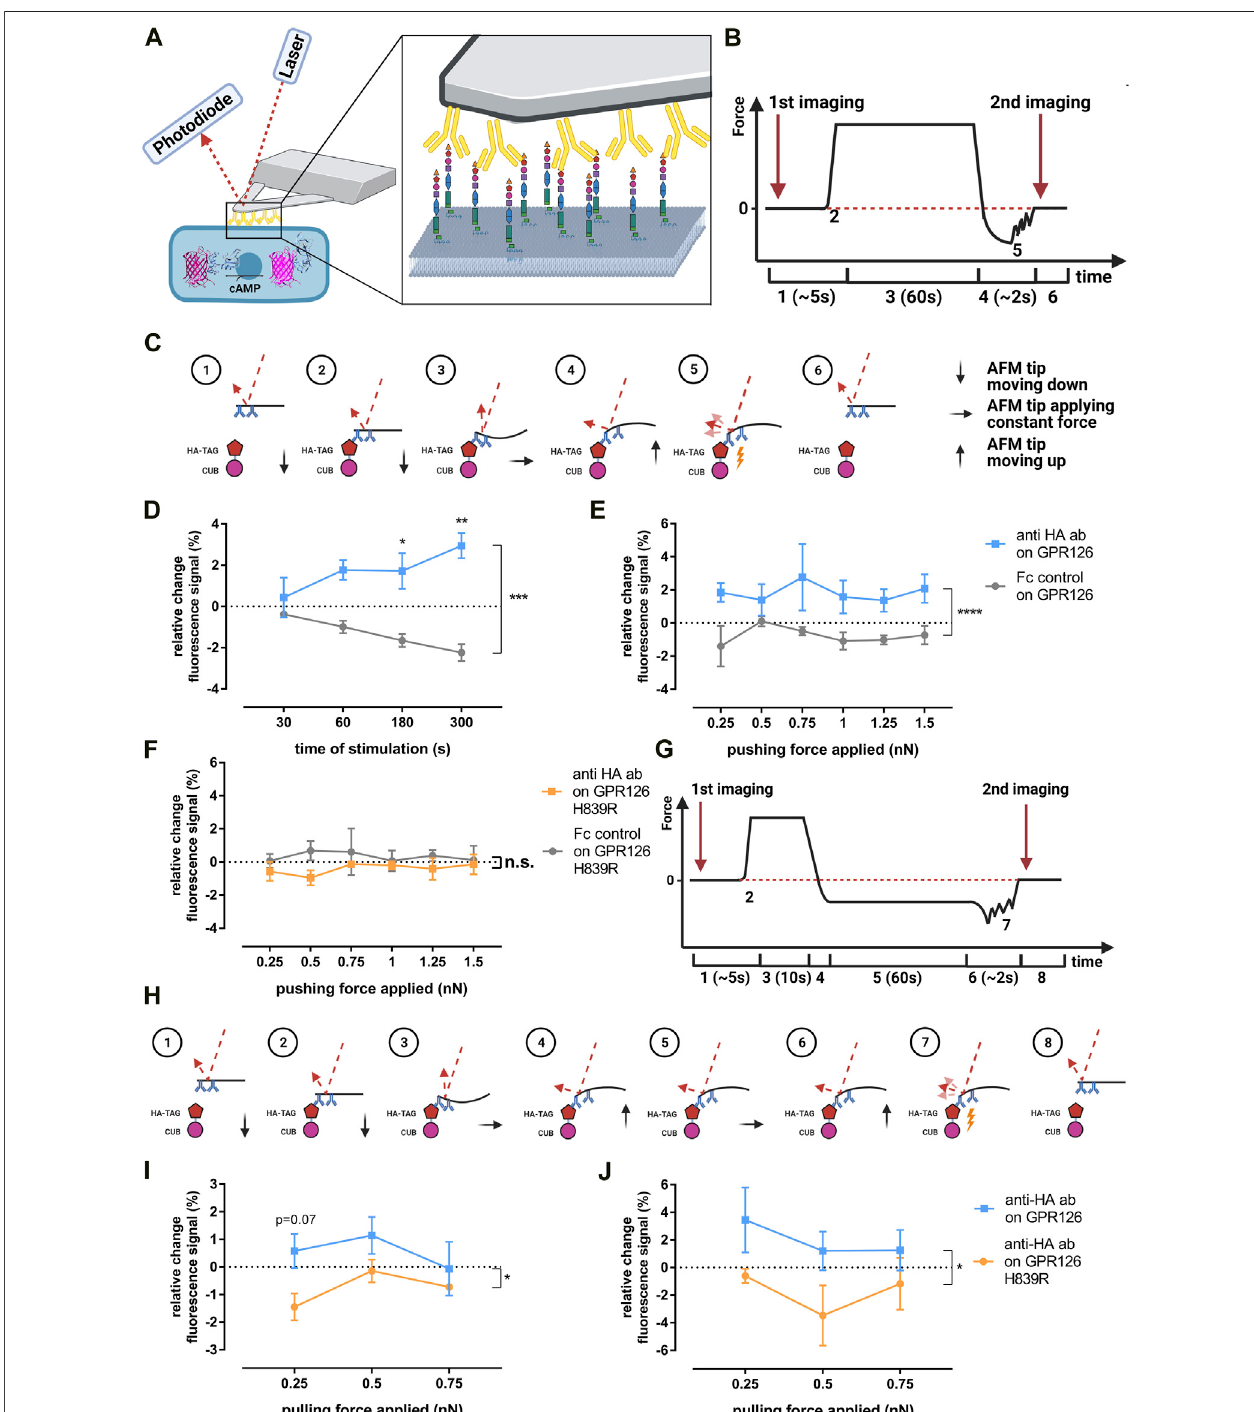
FIGURE 3 | Evaluating potential mechano-activation of GPR126 via anti-HA antibodies. (A) Schematic AFM experiment setup with a coated tipless cantilever pressing on a cell co-transfected with GPR126 and the Pink Flamindo cAMP sensor. (B,C) Course of the AFM cantilever de fl ection during the pushing experiments and the forces applied to the receptor and corresponding laser de fl ection: (Monk et al., 2009) cantilever approaches cell; (Monk et al., 2011) point of contact between the cantilever and cell; (Mogha et al., 2013) constant pressure being applied to the cell; (Ravenscroft et al., 2015) cantilever is retracted from the cell; (Mogha et al., 2016) rupture of cantilever bindings; (Sun et al., 2020) all bindings are ruptured and the cantilever is back in its starting position. (D) Changes in Pink Flamindo fl uorescence intensity after applying apushing force of 1 nN on the WT receptor at different time points (effect oftime p =0.775, effect of coating p = 0.0002, interaction